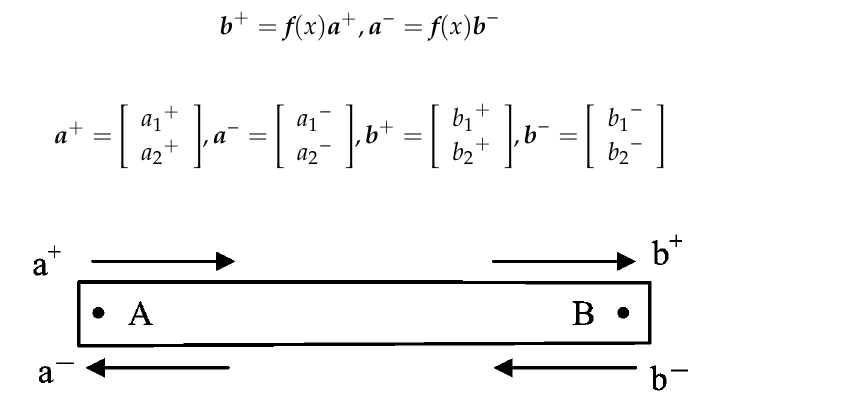
Figure 1. Wave propagation at two points separated by a distance x along a uniform beam.